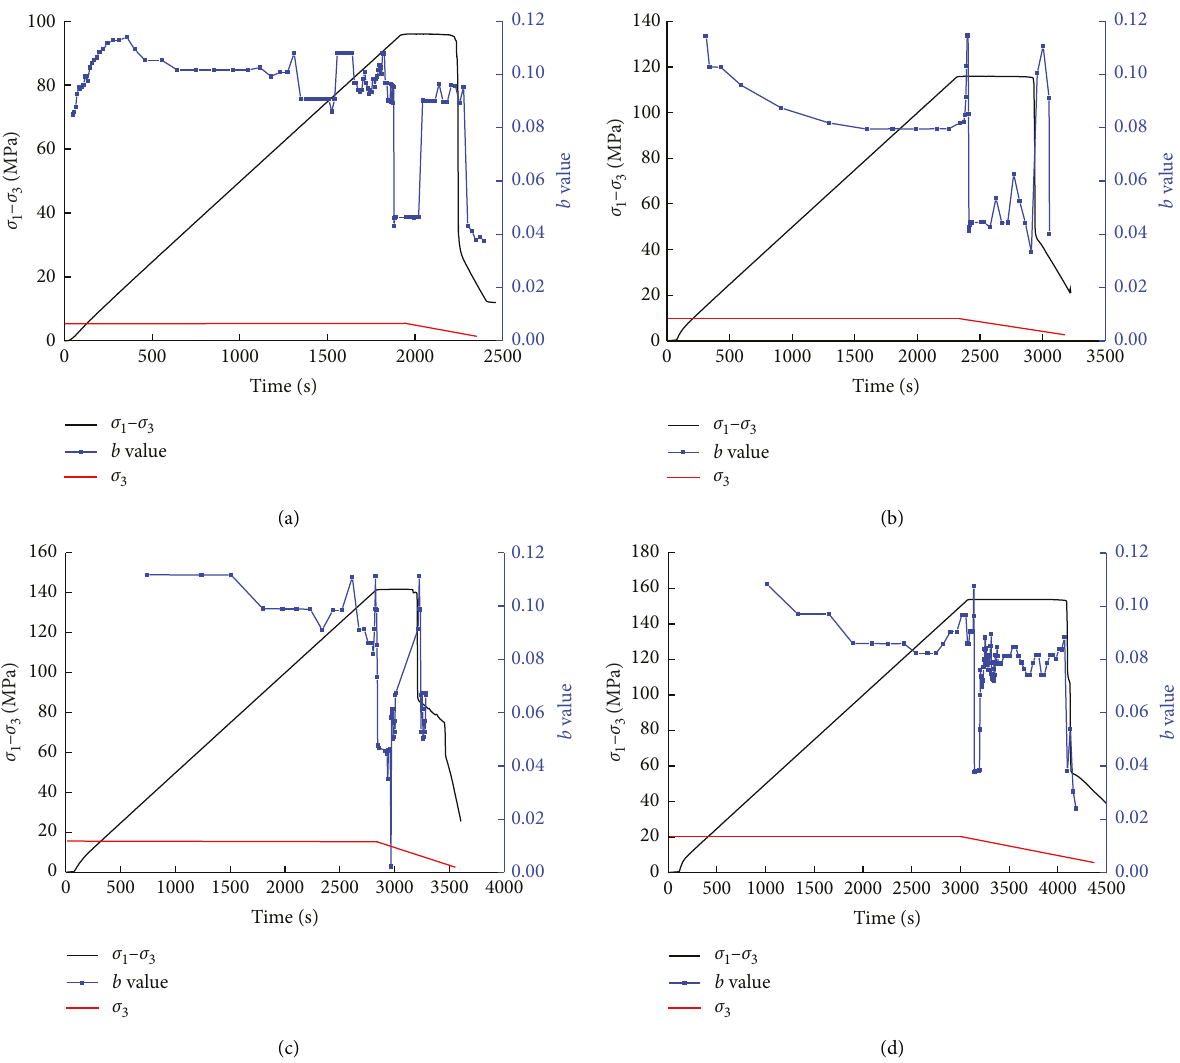
Figure 7: Time- b value of AE curves under unloading confining pressure. (a) The initial value σ (c) The initial value σ 3 � 15MPa. (d) The initial value σ 3 � 20MPa.